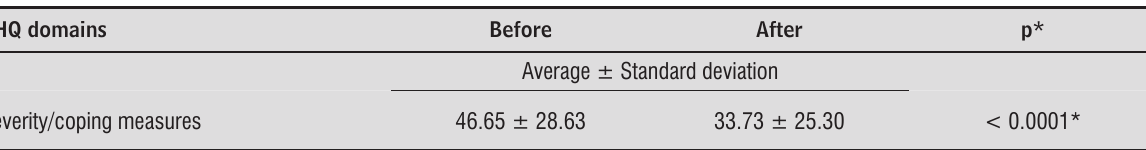
Table 2 - Variations of the domains before and after guidance KHQ domains Before